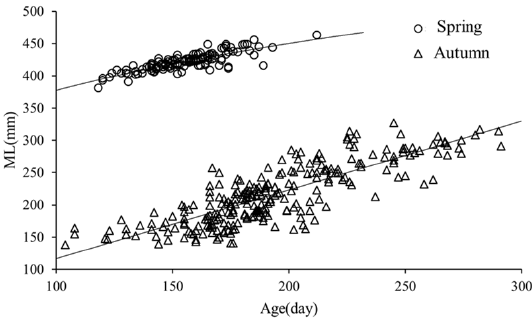
Table 2. Parameters of the linear, power, exponential, and logarithmic growth models fitted to the ML-age relationships of the S. oualaniensis samples.